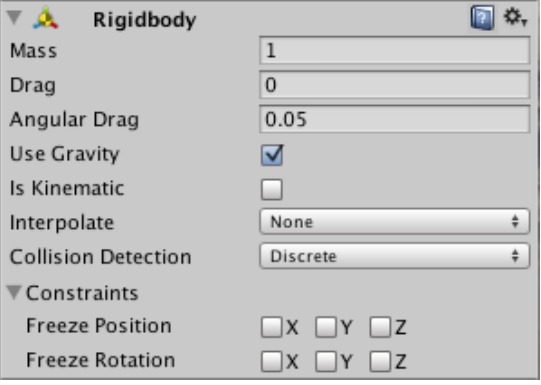
Figure 19. “ Rigidbody ” component. Figure 19. “Rigidbody” component.